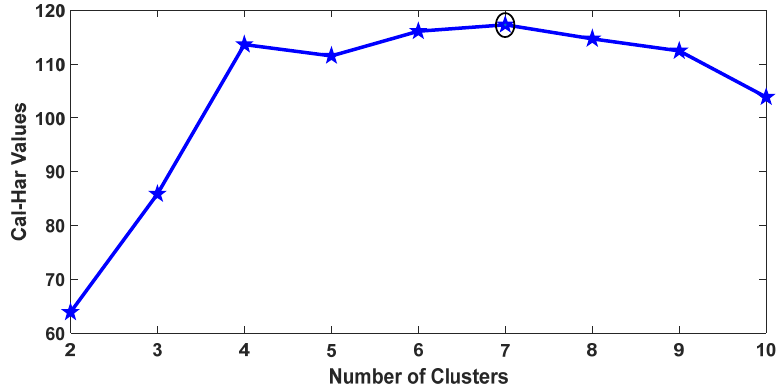
Figure 13. Optimal number of clusters: Cal–Har criterion. Sensors 2020 , 20 , x FOR PEER REVIEW